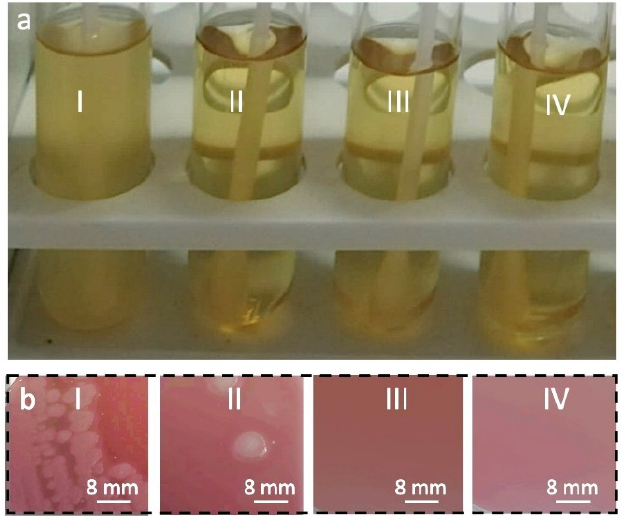
Figure 1. Analysis of microbiological purity of cotton fabric samples: ( a ) test tubes with agar after incubation, ( b ) photographs of the agar from the test tubes after incubation. Fabric sample not disinfected ( I ), fabric samples disinfected with 0.8% of OXONE ( II ); 0.2% TBA-OXONE ( III ); IV 0.4% TBA-OXONE ( IV ).